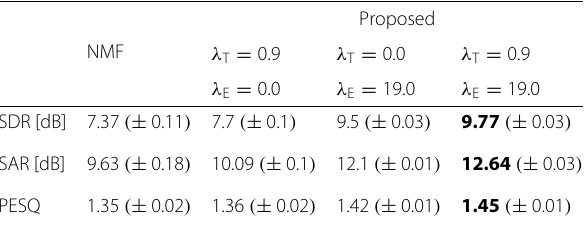
audio only-based NMF for different λ T and λ E . Ego-noise is caused by movements of Sequence I ( K = 20, K S = 20, SNR